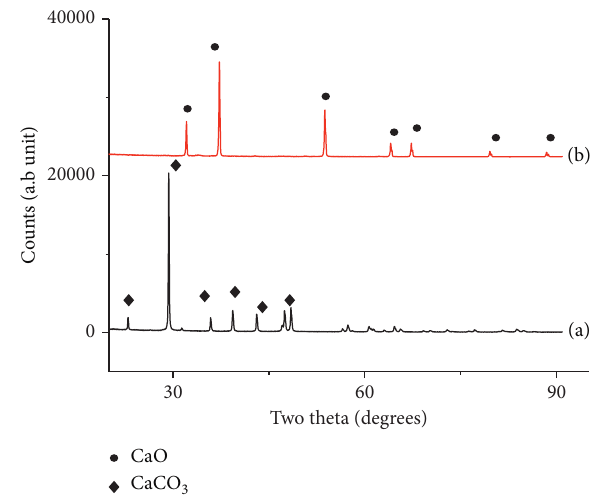
Figure 3: XRD pattern of samples: (a) chicken eggshell (black); (b) chicken eggshell ash-derived CaO calcined at 800 ° C (red).